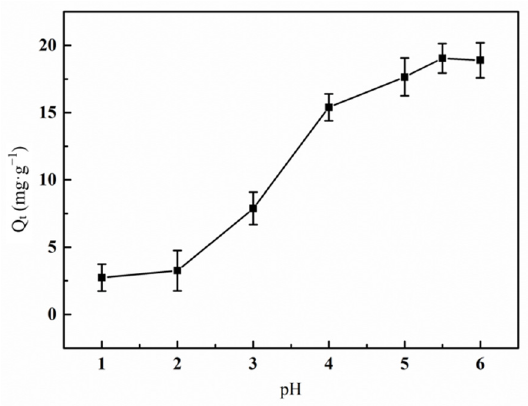
Figure 10. Effect of pH value on the adsorption of Hg(II) ions by graft polymer (contact time 120 min; initial concentration of Hg(II) ion 15 mg·L − 1 ; treatment temperature 45 °C).